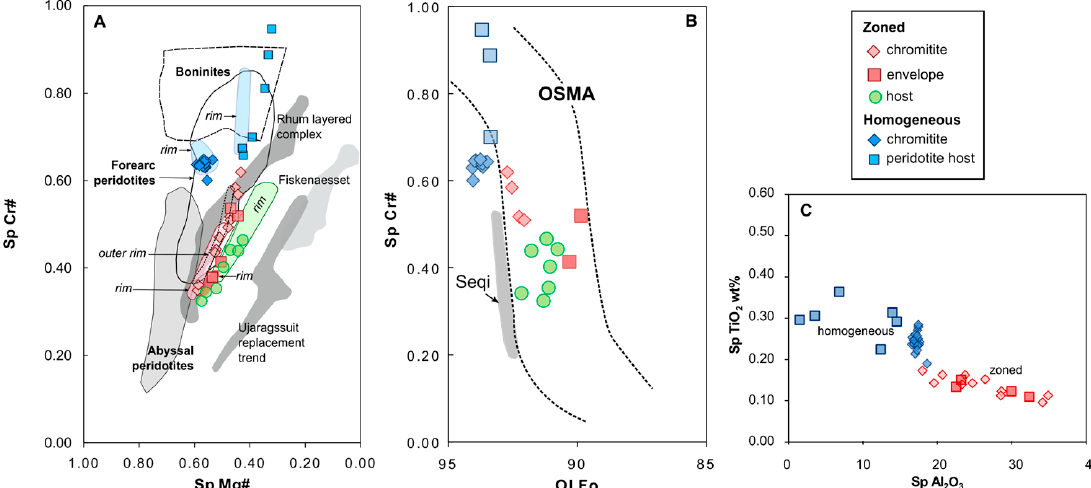
Figure 4. ( A ) Spinel Mg# [(Mg/Mg + Fe 2+ ) atomic ratio] vs. Cr# [(Cr/Cr + Al) atomic ratio] plot showing higher and less variable Cr# and Mg# for the homogeneous chromites, while zoned